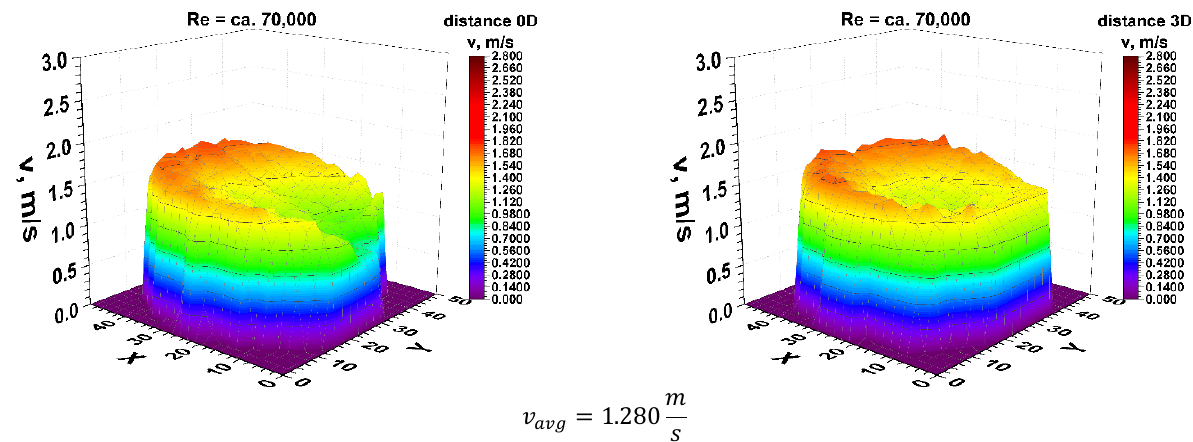
Figure 5. Comparison of velocity blocks at the distances 0D and 3D from the disturbance obtained by means of LDA measurements for Re ≅ 70,000.